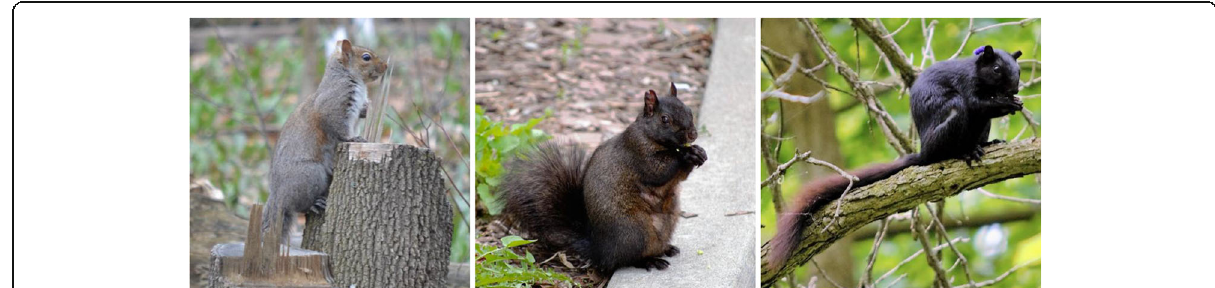
Fig. 1 Representative photos of the (left) agouti (zero copies of the melanism causing MC1R- Δ 24 mutant allele), (centre) intermediate (one copy of the MC1R- Δ 24 mutant allele), and (right) black (two copies of the MC1R- Δ 24 mutant allele) eastern grey squirrel ( Sciurus carolinensis ) coat colour